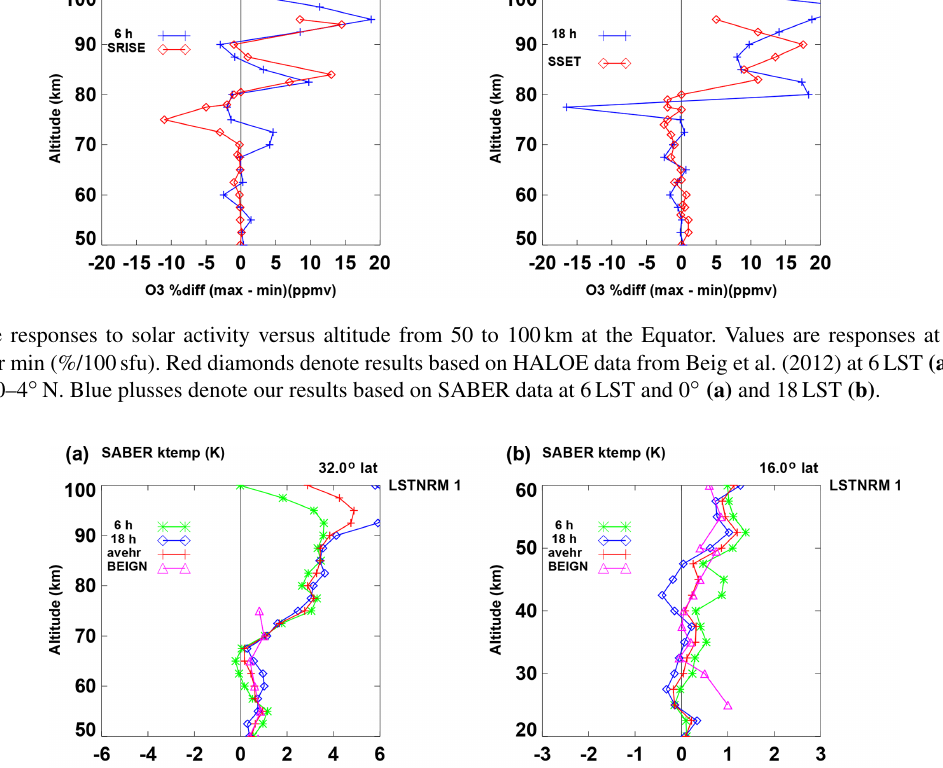
are averages over both longitude and a 24 h local time pe- riod. The green asterisks denote responses for 6 LST, blue di- amonds represent 12 LST, red plusses represent 18 LST, and magenta triangles represent 24